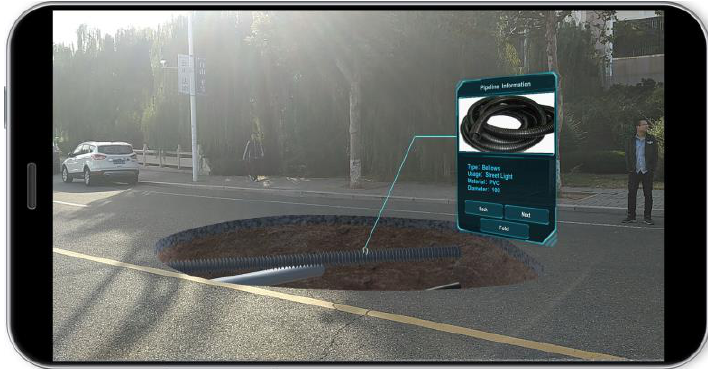
Figure 11. Display of the pipeline information.